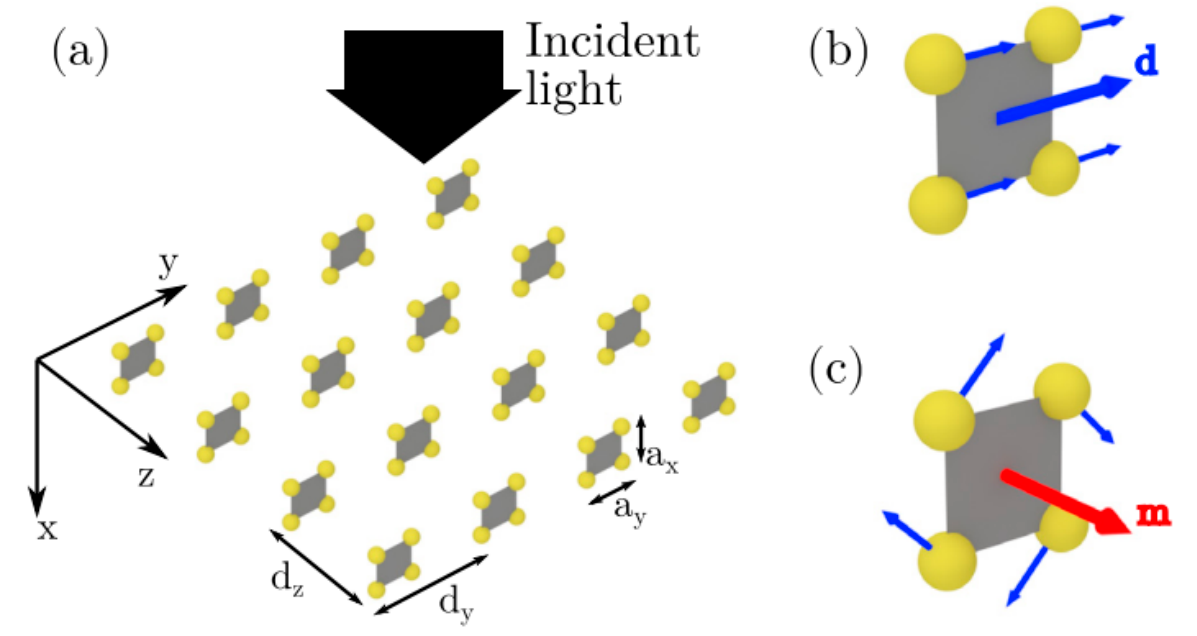
Figure 26. ( a ) Two-dimensional square lattice constituting an atomic Huygens surface with four atoms per unit cell. ( b ) An electric dipole moment, d (given by the vectorial sum of the individual dipole moments identified by the ticker blue arrows), is generated by the uniform polarization in the unit cell. ( c ) A magnetic dipole moment, m, is generated by the azimuthal polarization. Figure reused from Ref. [136] under the terms of the Creative Commons Attribution 4.0 International License.